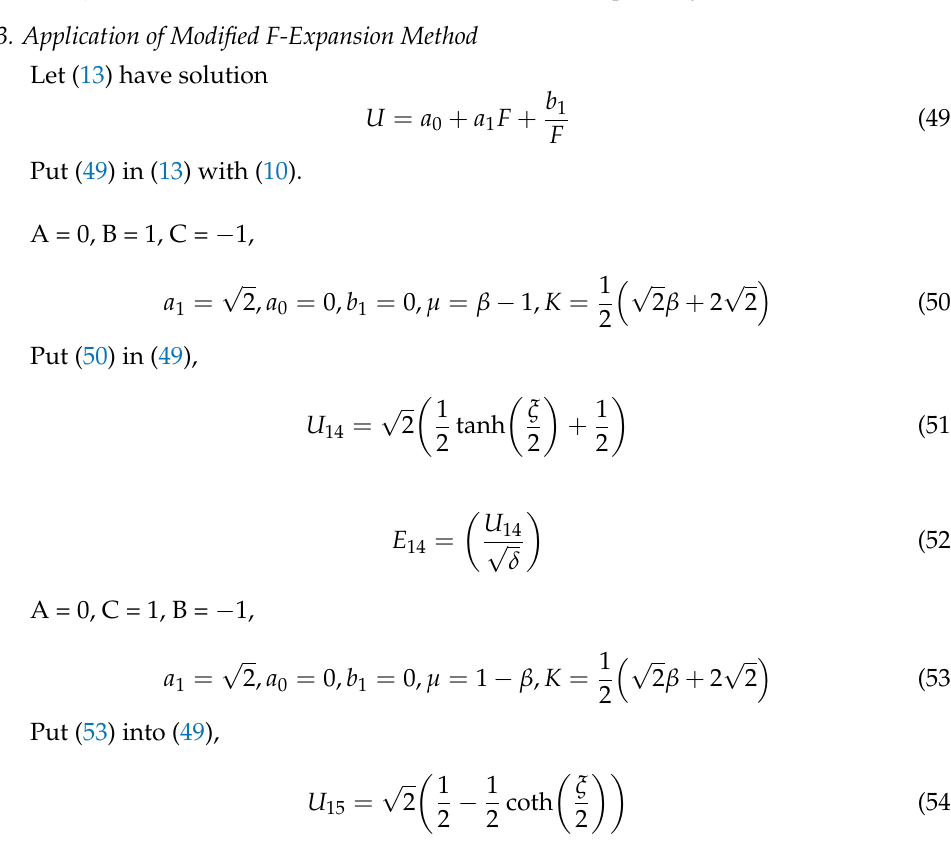
Figure 3. Solutions of U 13 ( a , b ) and E 13 ( c , d ) with α = 1, β = 0.01, c 0 = 1.1, c 2 = − 0.0001, τ = − 0.01 and α = 1, β = 3.1, c 0 = − 2.1, c 2 = − 0.01, δ = − 0.5, τ = 0.01,